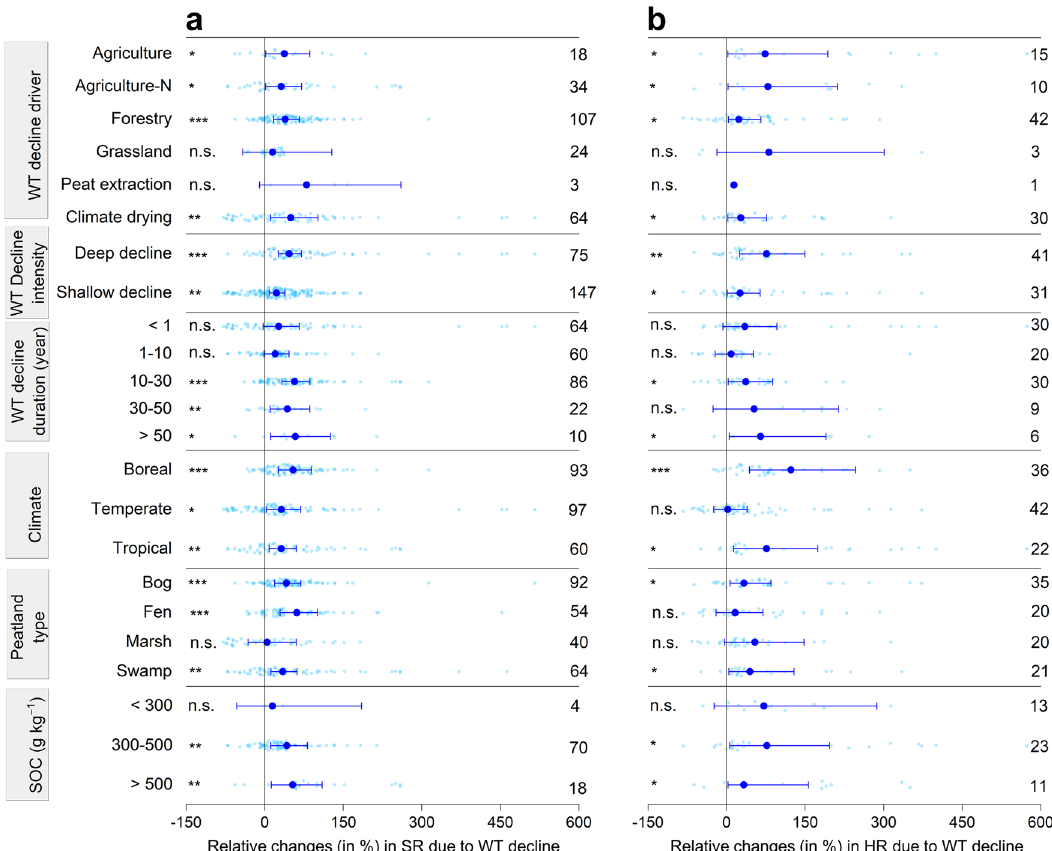
Fig. 2 Relative changes in soil respiration (SR) and heterotrophic respiration (HR) under different conditions due to water table (WT) decline in pristine peatlands. a Relative changes in SR due to WT decline. b Relative changes in HR due to WT decline (AR was not shown due to the scarcity of data points ( n = 35)). The larger solid circles and horizontal bars denote the weighted means of relative changes and their 95% con fi dence intervals. The smaller circles and the numbers indicate individual relative changes due to WT decline and numbers of data points, respectively. The asterisks *, **, *** indicate signi fi cance at the levels of p < 0.05, 0.01 and 0.001, respectively, and n.s. indicates no signi fi cance (for details, see Meta-analysis in Methods). Net water table declines greater and less than 30 cm are de fi ned as deep and shallow declines, respectively, according to ref.